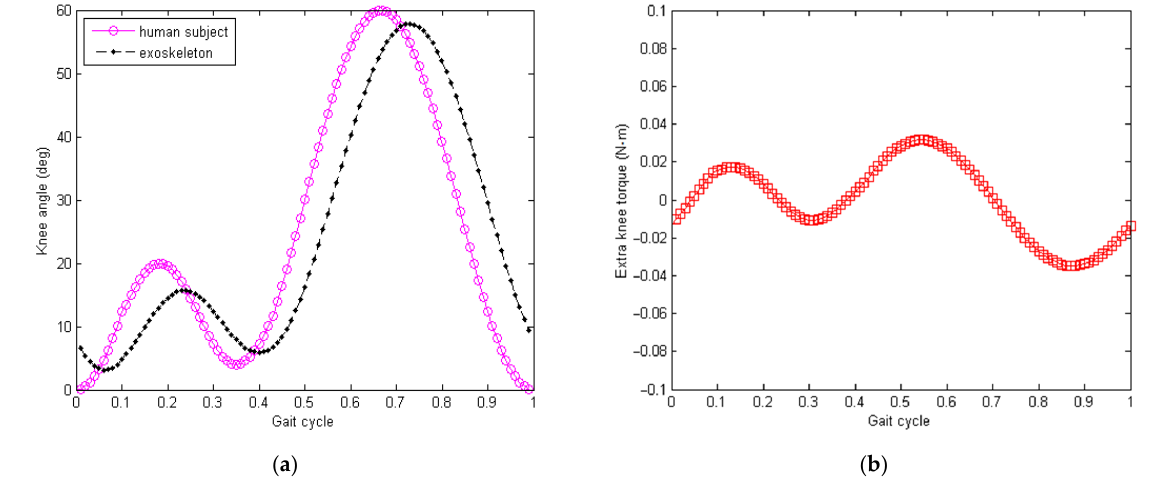
Figure 4. Energy loss due to contact interaction between human subject and exoskeleton bracket. ( a ) Simulated loss of swing amplitude from the knee joint of human subject’s lower limb to the exoskeleton. ( b ) Simulated extra torque load applied to the knee joint of the human subject.